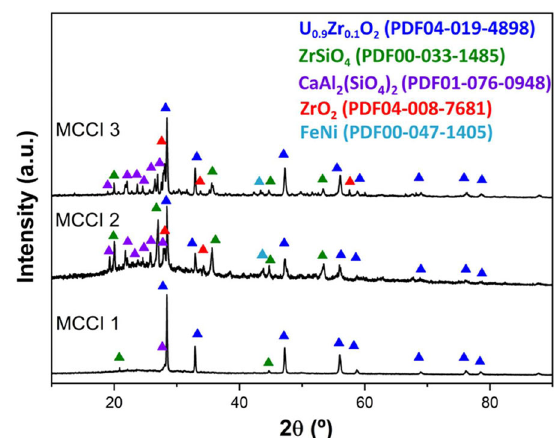
Fig. 1 X-ray diffraction data obtained for each of the three MCCI